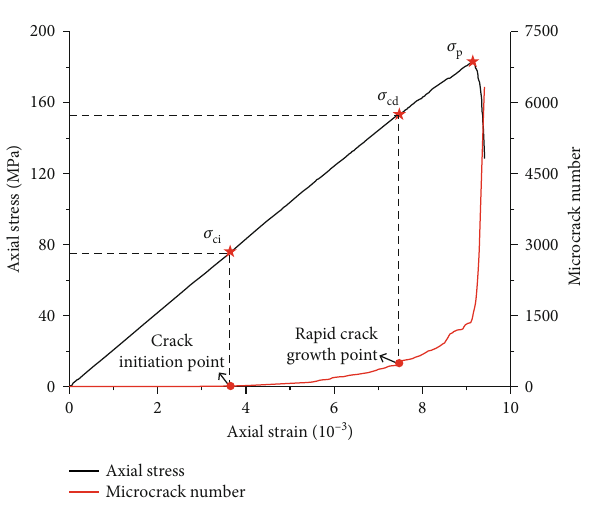
Figure 9: Change curve of the microcrack number in intact numerical model.